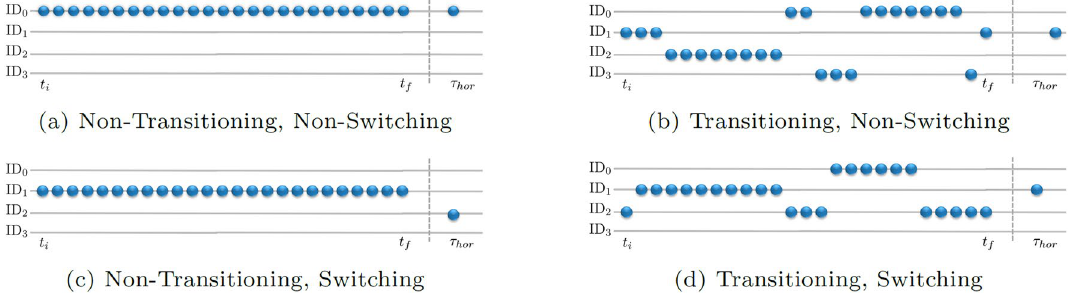
Figure 3. Illustration of the different sub-categories of target selection behavior, which also reflects the four different types of data samples used for model training and testing. Non-transitioning ( a , c ) and transitioning ( b , d ) corresponded to whether a harder corralled the same target or different targets during the input sequenced T seq = t ∈ [ t i ,t f ]. Non-switching ( a , b ) and switching ( c , d ) corresponded to whether a herder was corralling the same or a different target, respectively, at T hor and t f .